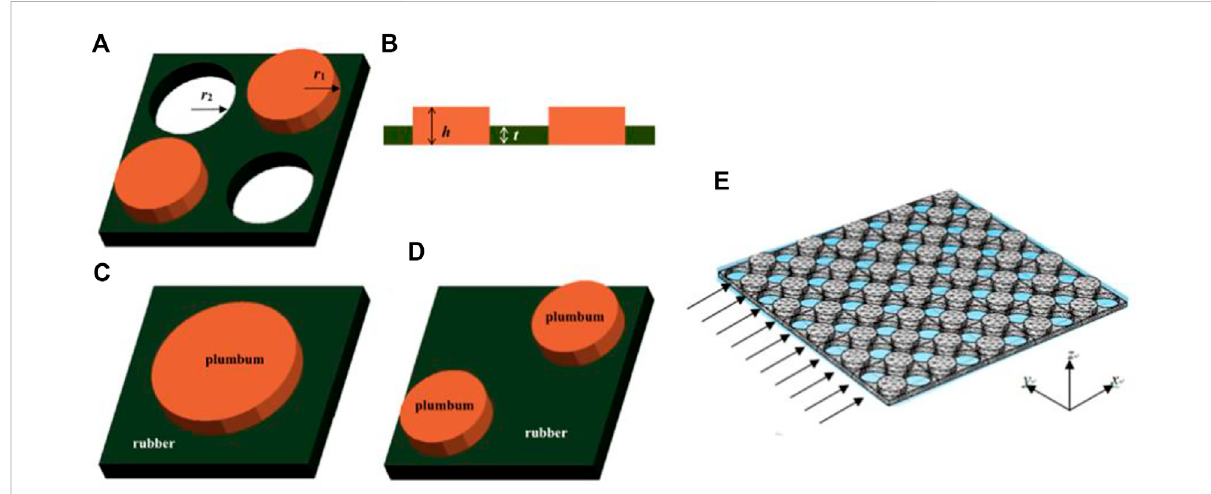
FIGURE 2 Unit cell of phononic crystal: (A) Novel PC plate; (B) Section of new PC plate; (C) Single short plate; (D) Thick plate with double short piles; (E) Incident situation of PCS. Reprinted from [39] with permission.